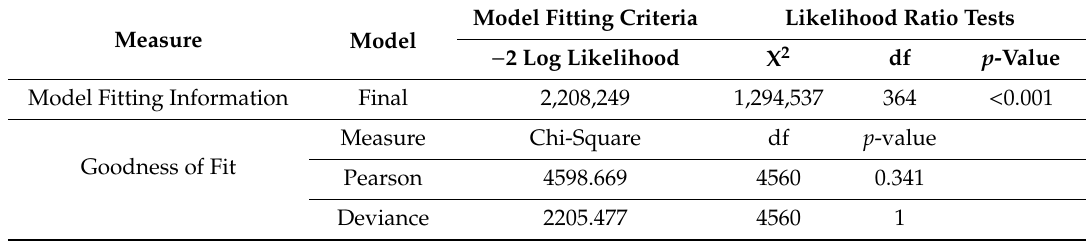
Table 2. Model fitting information and goodness of fit of the Multinomial Logistic Regression (MNL)